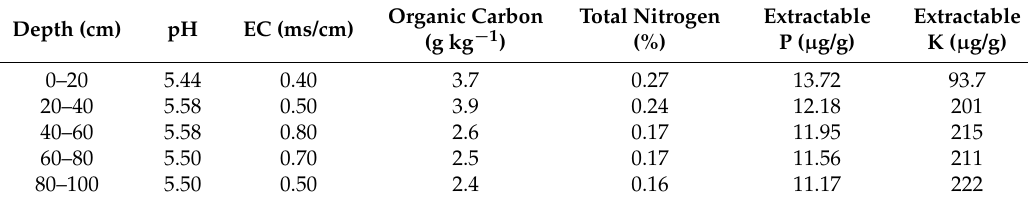
Table 2. Chemical properties of the paddy soil in the experimental